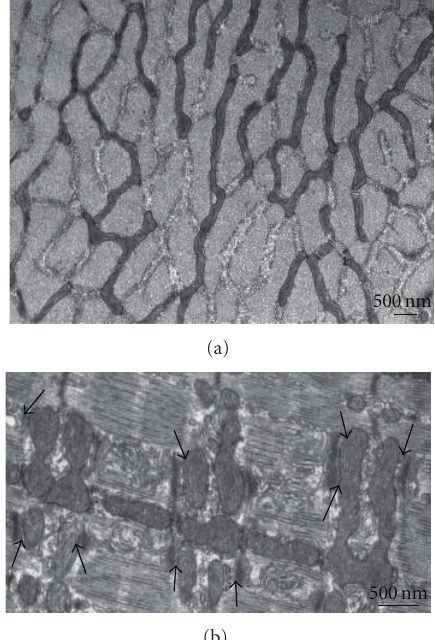
Figure 1: Cross (a) and longitudinal (b) sections of muscle fibers from the mouse EDL muscle. In (a), slender, elongated approxi- mately cylindrical mitochondria profiles occupy the intermyofib- rillar spaces, running transversely for long distances between the myofibrils at the I band level. In (b), the longitudinal axis of the fiber runs from left to right at a slight angle. Longitudinally arranged mitochondria send out transverse branches at the level of the I band, that correspond to those seen in (a). The transverse mitochondria branches run parallel to triads (CRUs) and are closely opposed to the junctional SR (arrows) over long